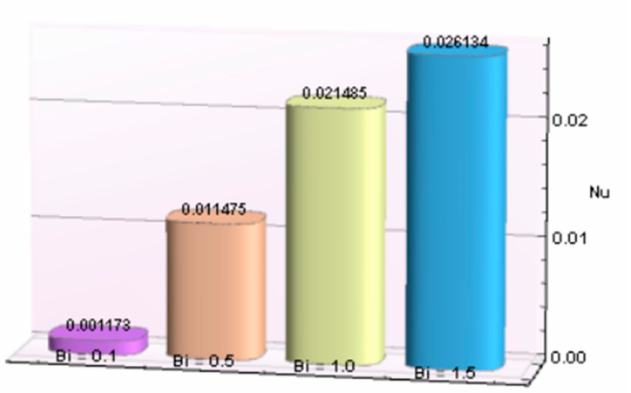
Figure 24. R verses Nu .